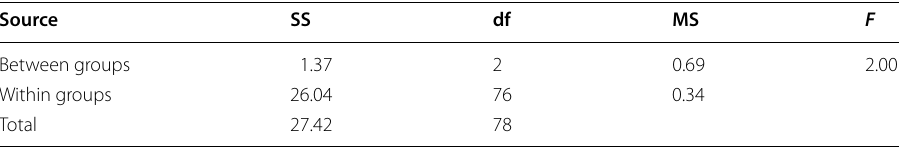
Table 5 The one-way ANOVA results of cognitive load scale Source SS df MS F Between groups 0.50 2 0.25 0.52 Within groups 36.49 76 0.48 Total 36.99 78